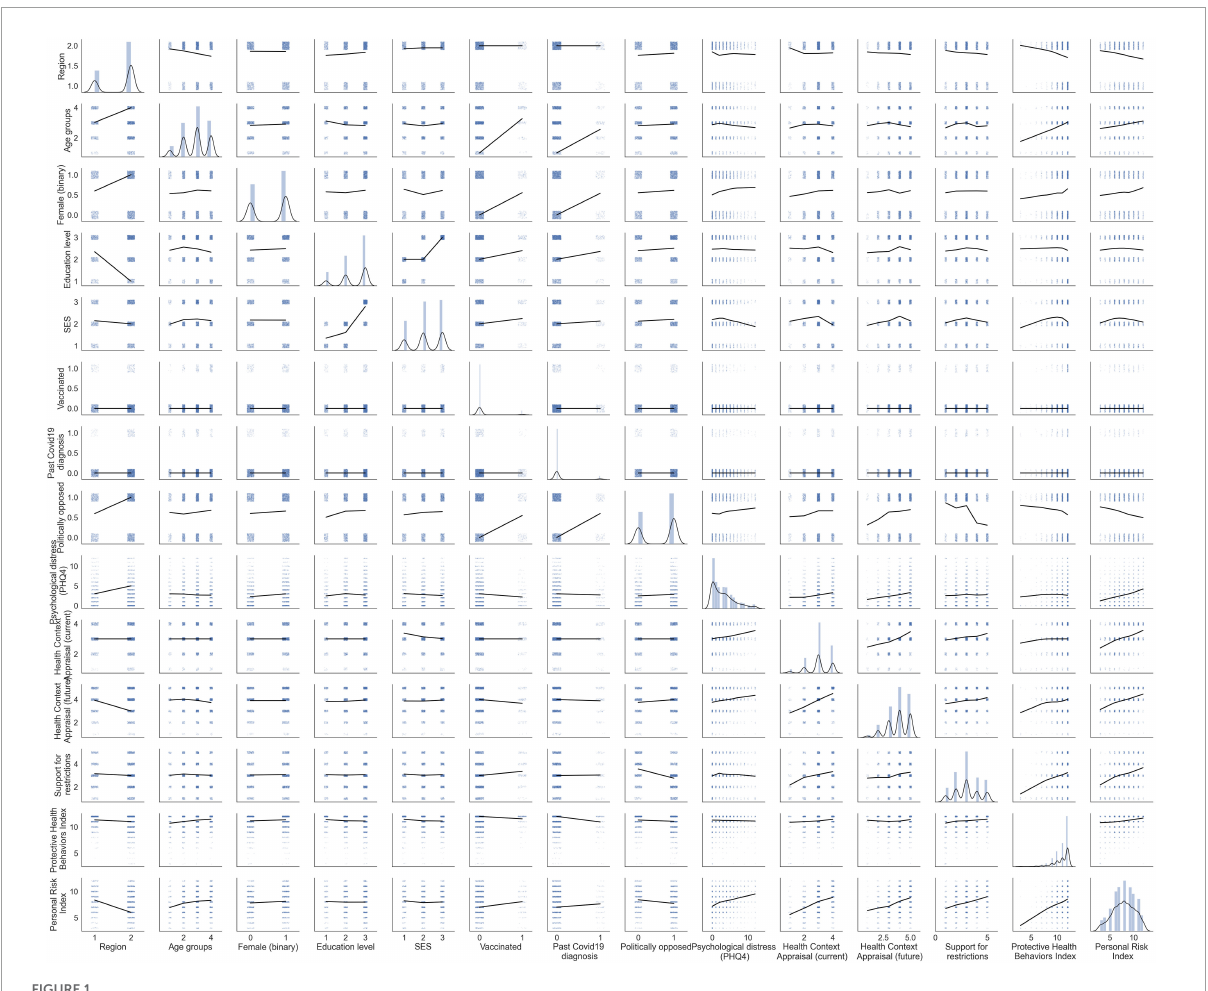
FIGURE1 Pairwise scatter plots between variables. Locally weighted linear regression lines are added for illustrative purposes of how the data is distributed, not for statistical inference. The univariate distributions are displayed on the diagonal.